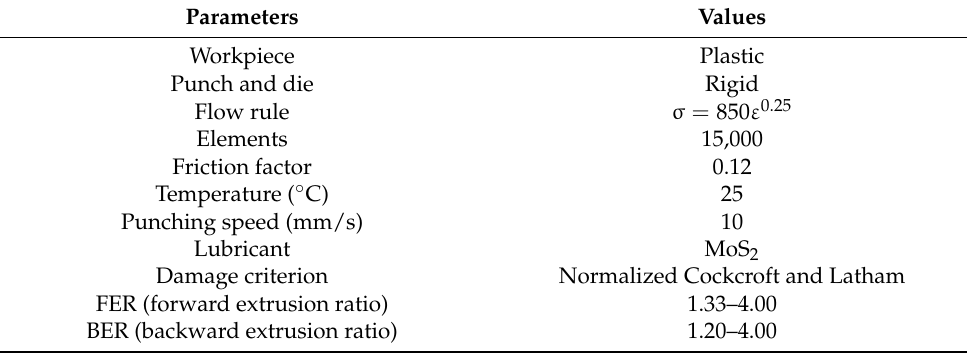
Table 2. Parameters used in